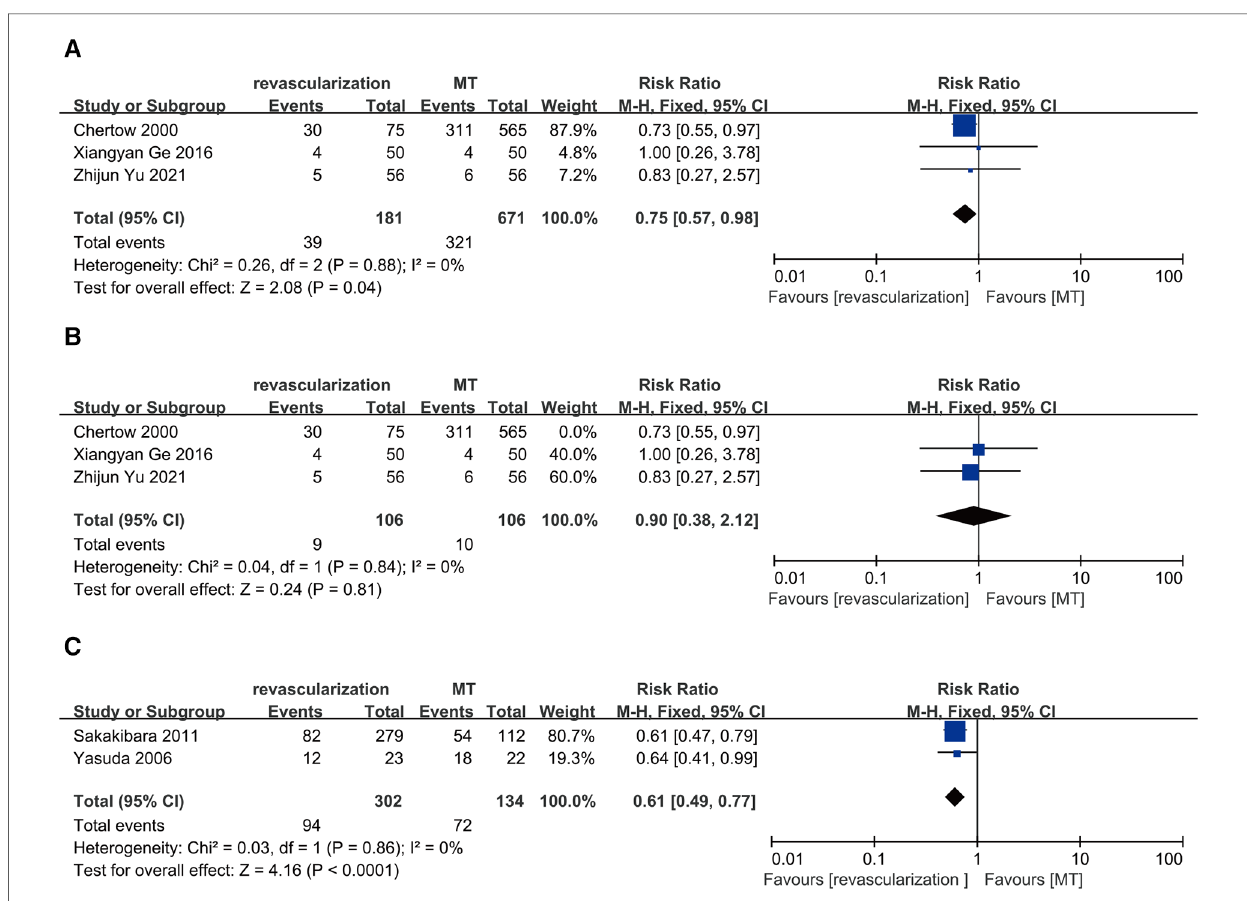
FIGURE 6 Long-term all-cause death: ( A ) revascularization vs. MT in maintenance dialysis patients with acute coronary syndrome; ( B ) revascularization vs. MT in maintenance dialysis patients with acute coronary syndrome with the exclusion of Chertow 2000. ( C ) revascularization vs. MT in maintenance dialysis patients with single-vessel disease. CI, con fi dence interval; MT, medical